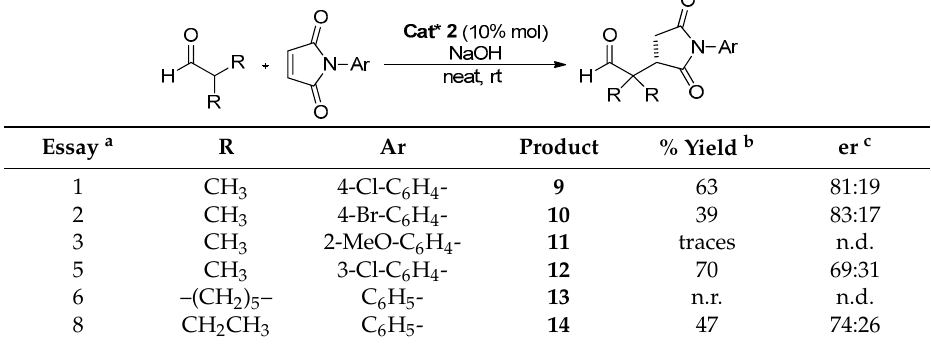
Table 3. Michael addition reaction of isobutyraldehyde to N -phenylmaleimide organocatayzed by phenylalanine- β -alanine (Phe- β -Ala, 2 ) in the presence of different bases.